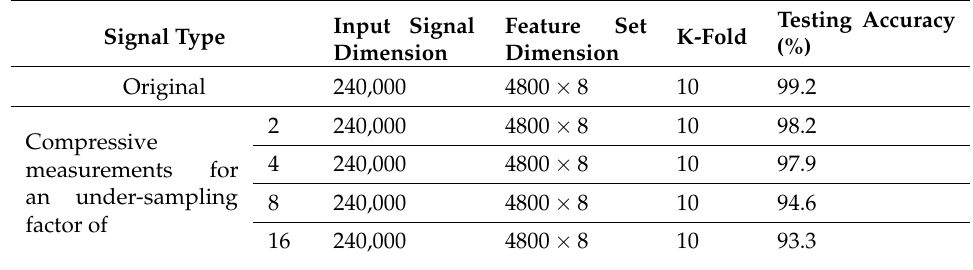
Table 1. Training and prediction accuracies of k -NN classifier for feature vectors obtained from original signal and from compressive measurements for different undersampling ratios.